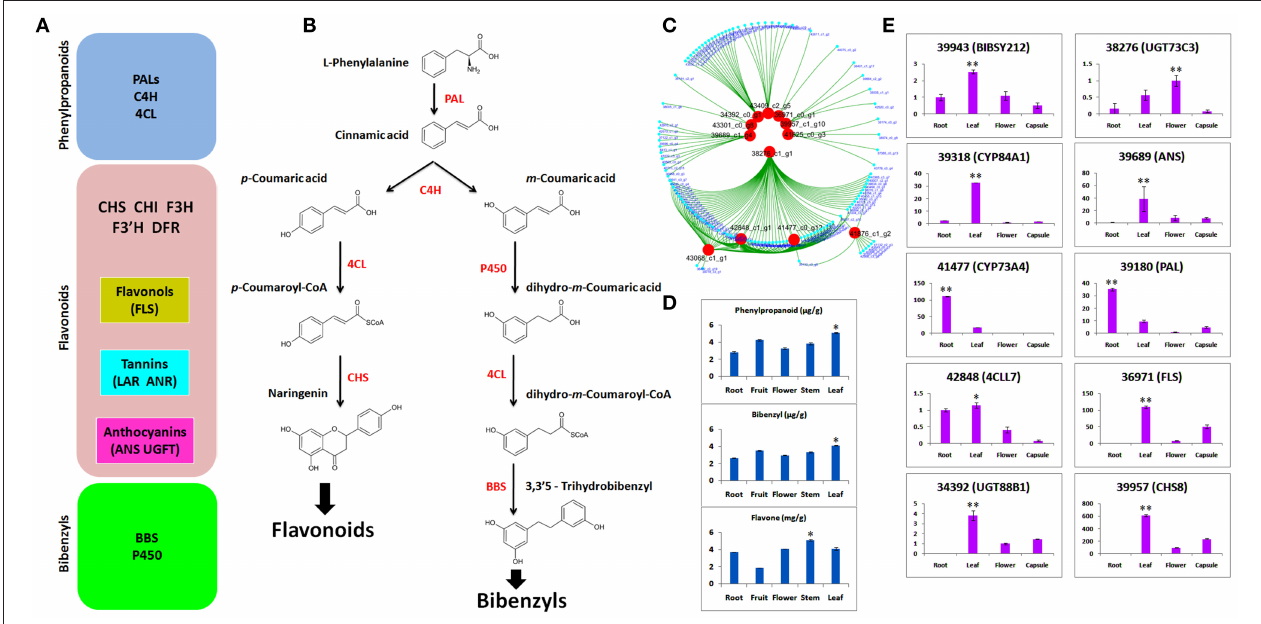
FIGURE 5 | (A) Gene regulators of phenylpropanoids, flavonoids, and bibenzyls; (B) biosynthesis route of flavonoids and bibenzyls. Colored in red are the enzymes that regulate different steps of biosynthetic pathways; (C) selection of candidates that involve biosynthesis of flavonoids and bibenzyls through coexpressed modules; (D) concentrations of phenylpropanoids, bibenzyls, and flavonoids through high-performance liquid chromatography-tandem mass spectrometry (HPLC-MS/MS); (E) quantitative real-time PCR (qRT-PCR) expression of 10 selected DEGs related to bibenzyl and flavonoid biosynthesis. The statistical significance is shown at p ≤ 0.05 (*) or p ≤ 0.01